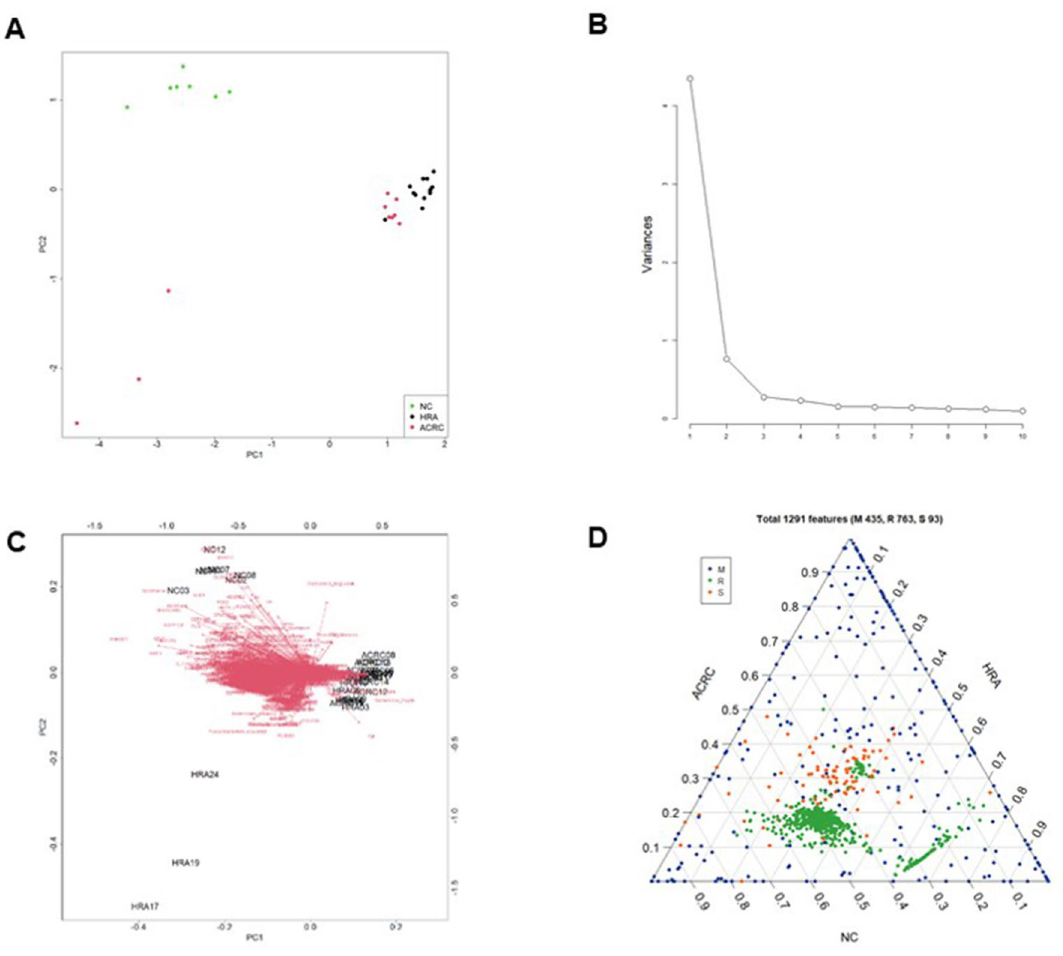
Figure 1. Integrative analysis and visualization of the 30 samples using three datasets. In the 30 samples (13 advanced colorectal cancers [ACRCs], 10 high risk adenomas [HRAs], and 7 normal controls [NCs]), there were 529 species identified by metagenome analysis and 763 genes identified by RNA sequencing. The survey results identified 93 associated variables. Each dataset was merged and normalized to a value between 0 and 1. Principal component analysis (PCA) was applied to reduce the dimension of features from each dataset, and 10 principal components (PCs) were retrieved. ( A ) Each two-dimensional PCA plot represents two PCs, reduced from 1385 features. ( B ) The scree plot represents 10 PCs. ( C ) The biplot represents the direction of each feature. ( D ) In the ternary plot, 1385 features corresponding to ACRCs, HRAs, and NCs are presented as points and are distinguished by three